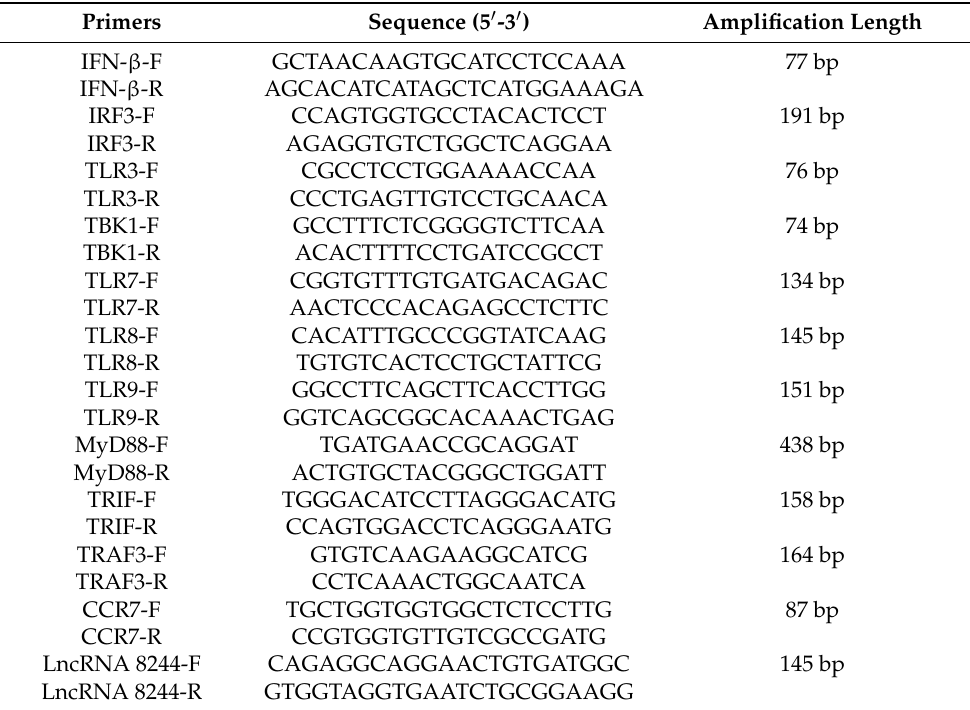
Table 1. Primers used for real-time